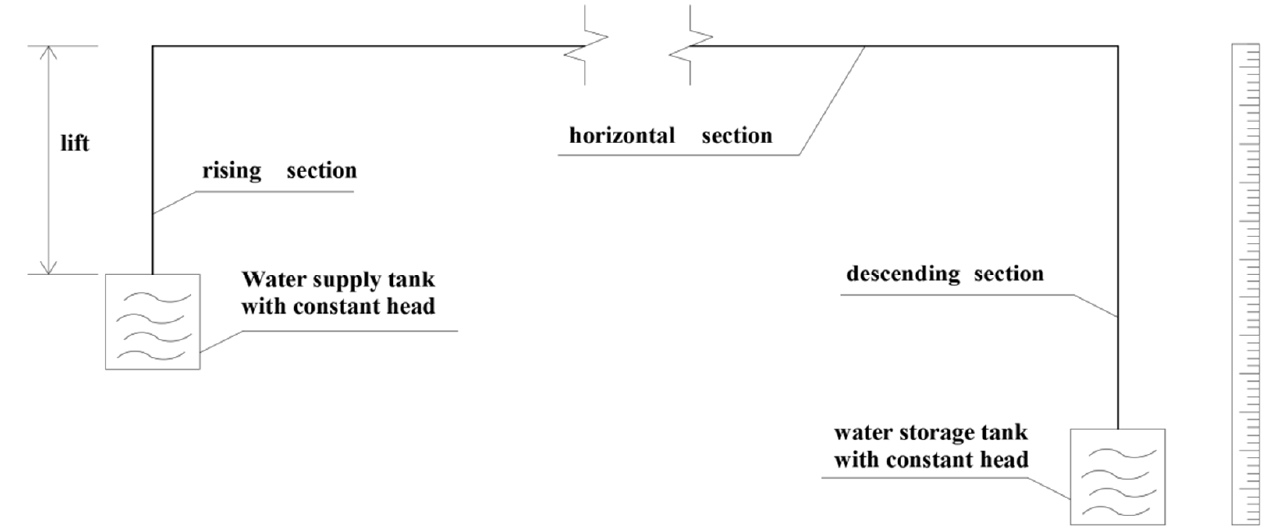
Figure 9. Diagram of the experimental setup. Table 1. Experimental schemes of siphon drainage (T = 25 °C, 𝑃 No.